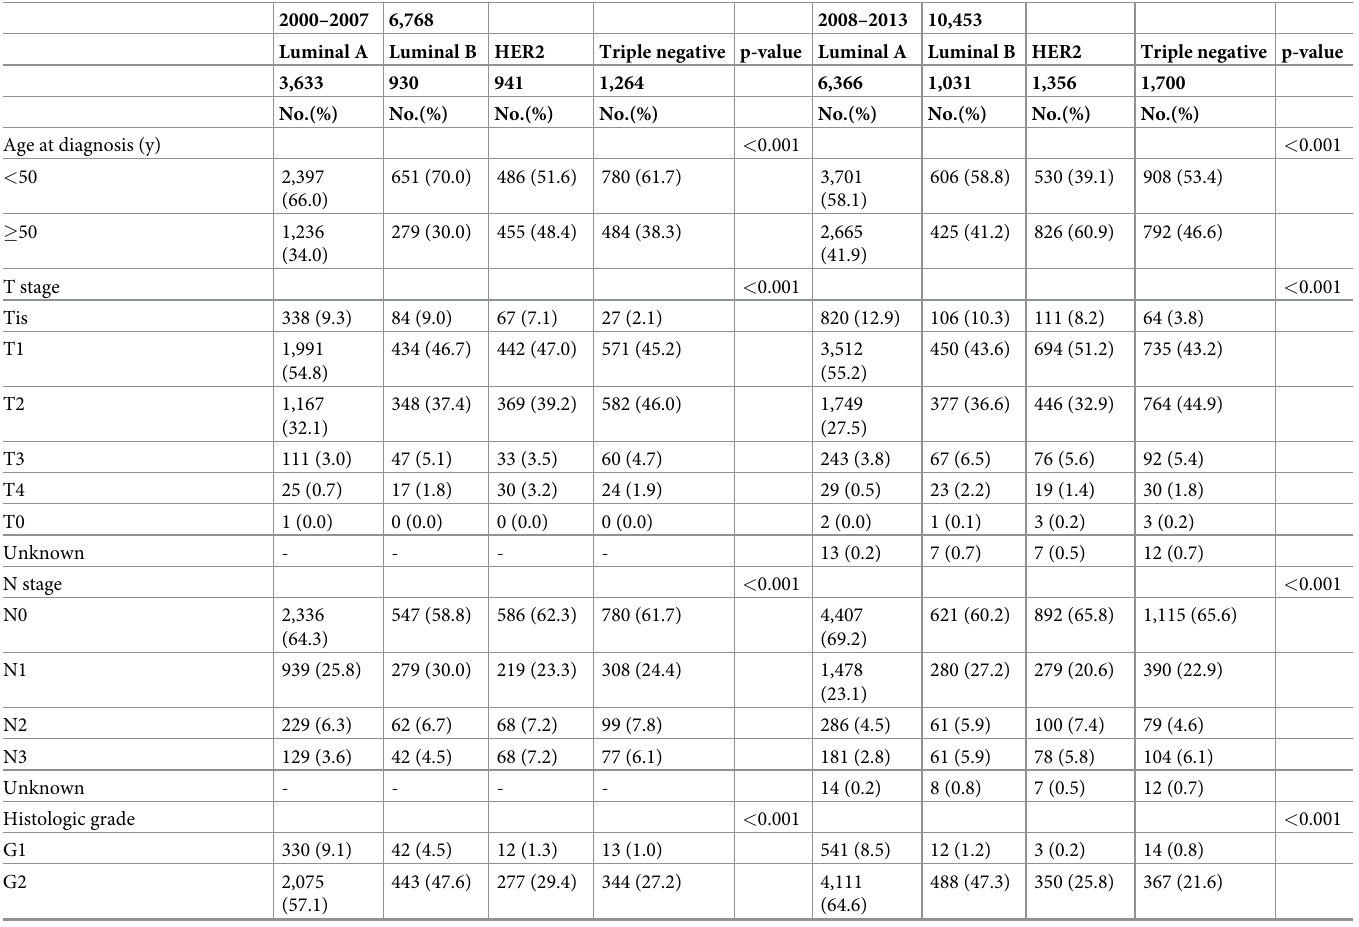
Table 3. Clinicopathological features of patients categorized by subtypes in each